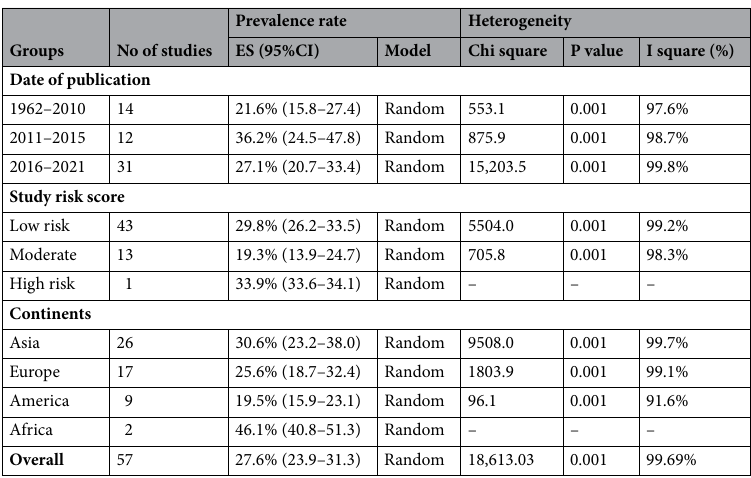
Table 2. Summary of meta-analysis results and subgroups